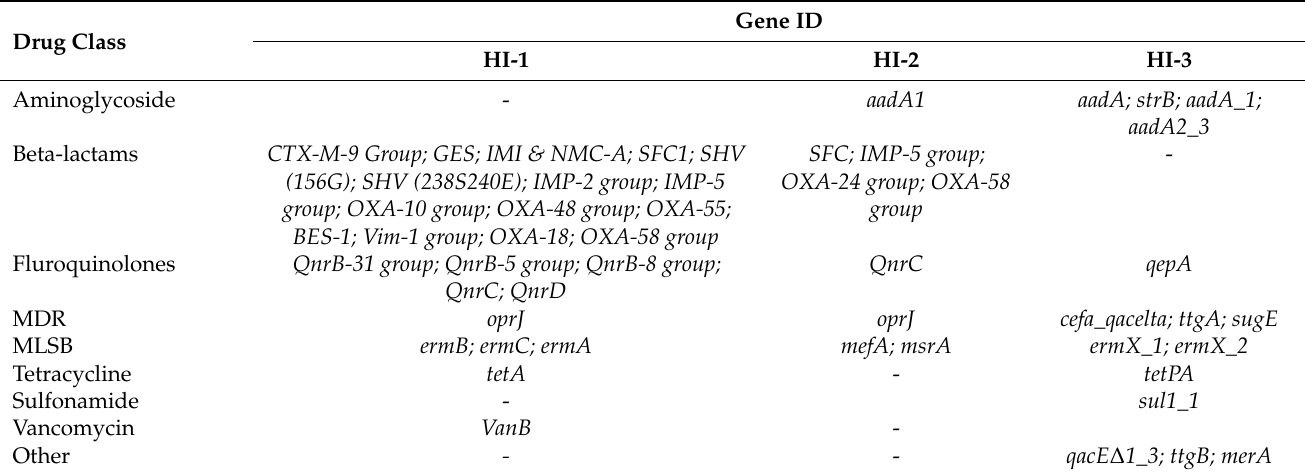
Table 1. ARGs and their drug classes detected in aerosols collected from clinical settings of Kuwait.